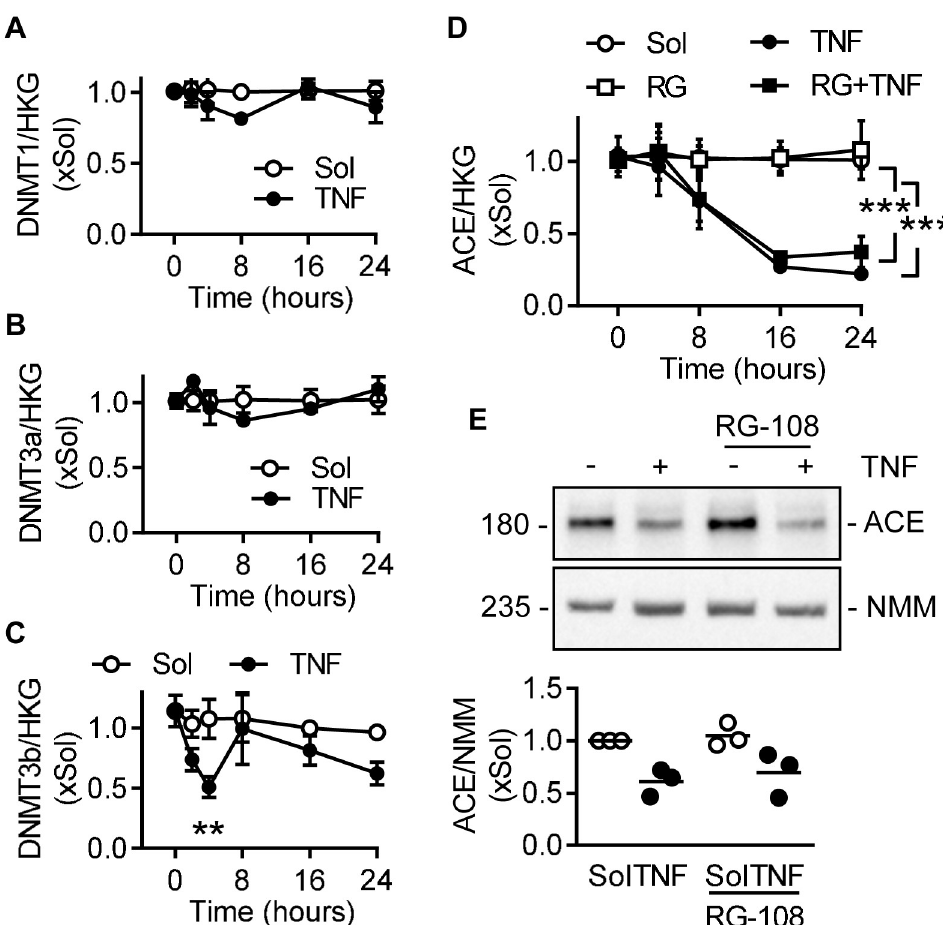
Fig 3. Expression of DNMTs in TNF α -treated human endothelial cells. (A-C) Time course of the effects of TNF α (10 ng/mL) on DNMT1 (A), DNMT3a (B) and DNMT3b (C) mRNA levels in human endothelial cells relative to a triplet of housekeeping genes (HKG); all n = 6 independent cell batches (two-way ANOVA/Bonferroni). (D-E) Effect of RG-108 (RG, 30 μ mol/L) on the expression of ACE in human endothelial cells treated with solvent (Sol) or TNF α (10 ng/mL). Time course of ACE mRNA (D); n = 4 independent cell batches (two-way ANOVA/Bonferroni) and ACE protein (E) relative to non-muscle myosin heavy chain (NMM) 24 hours after treatment; n = 3 independent cell batches. �� P < 0.01, ��� P <